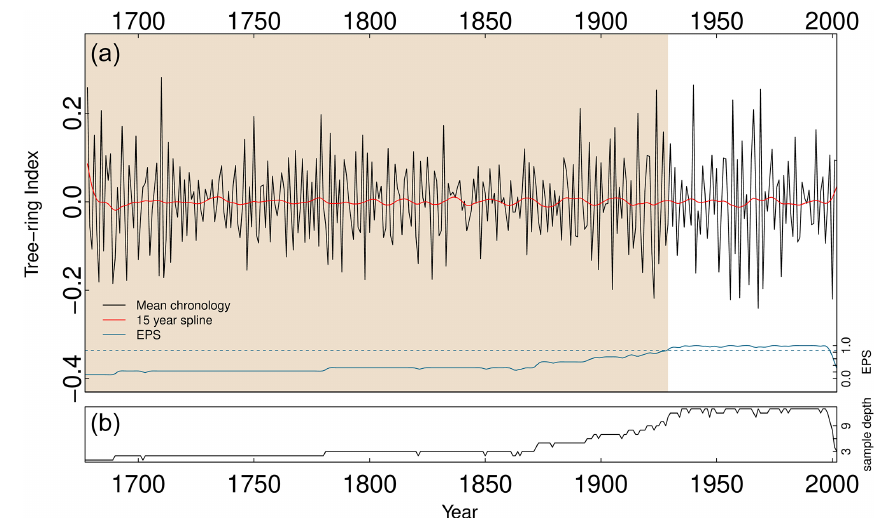
Figure 4. Full mean ring-width chronology (1676–2002) based on 13 Mt Loch P. lawrencei series from 9 samples (a) , with concurrent sample resolution (b) . Expressed population signal (EPS) is denoted by the solid blue line (a) , with the 0.85 threshold (dashed blue horizontal line).